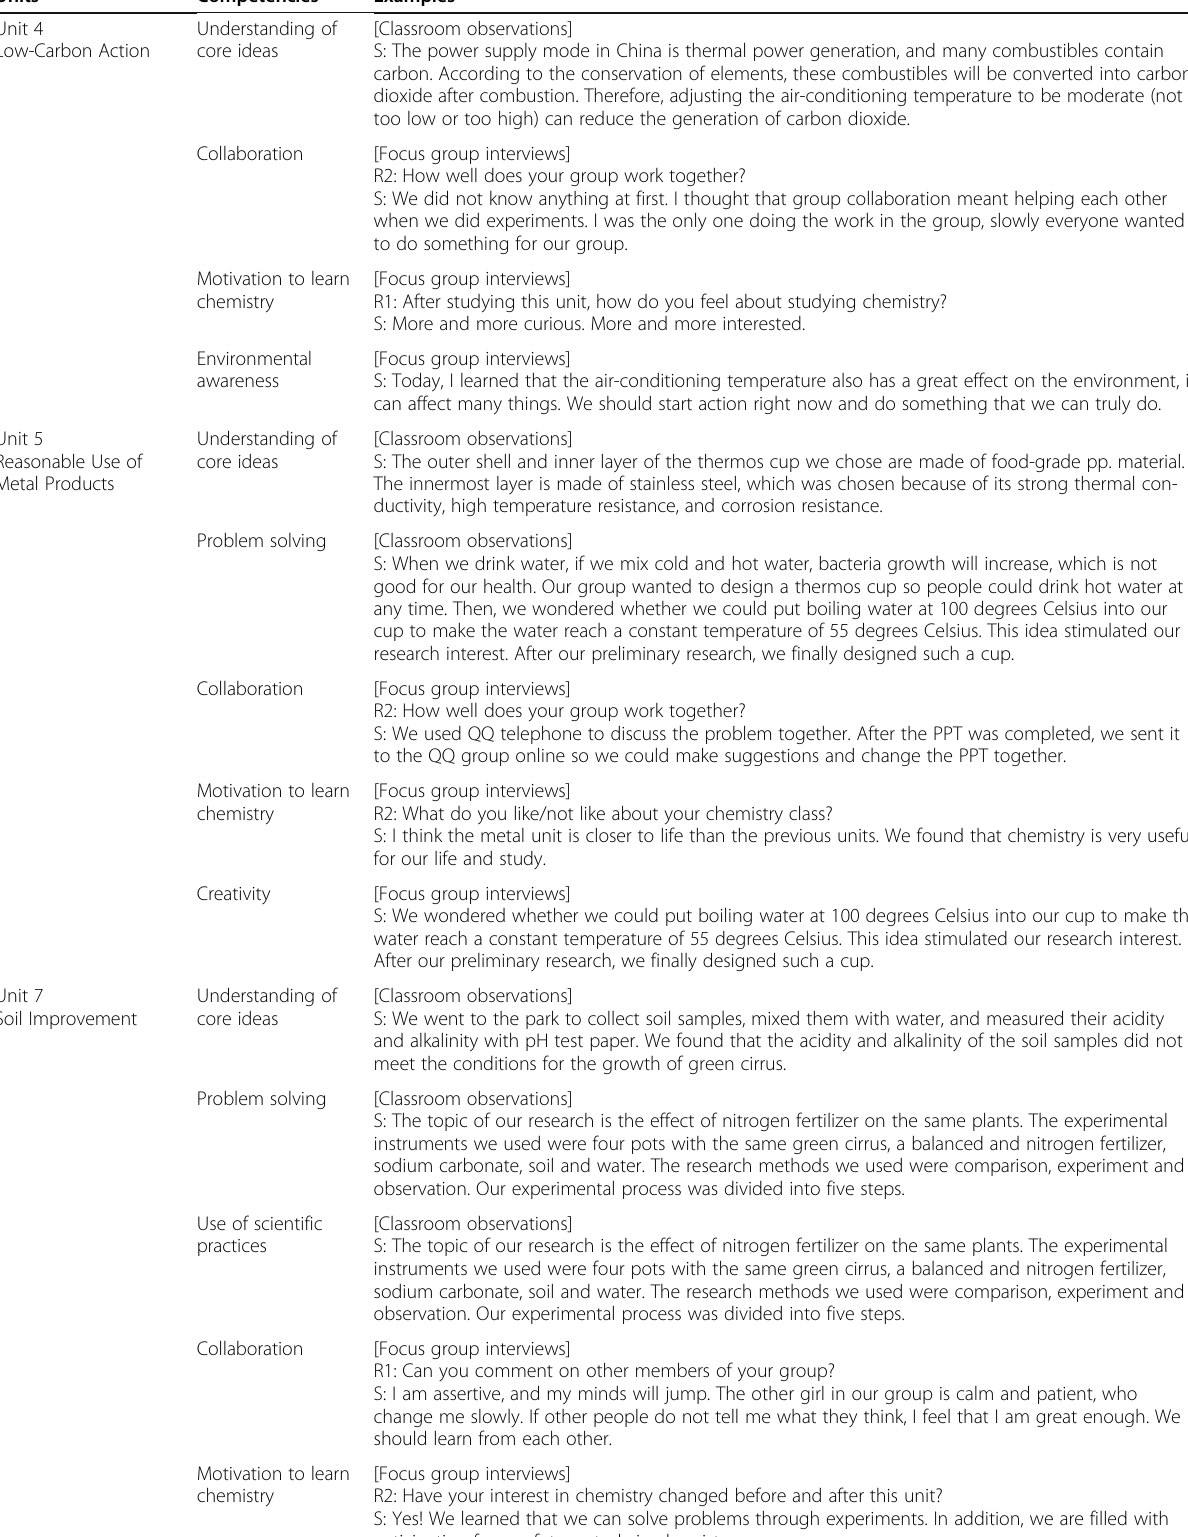
Table 4 Results of categorizing the